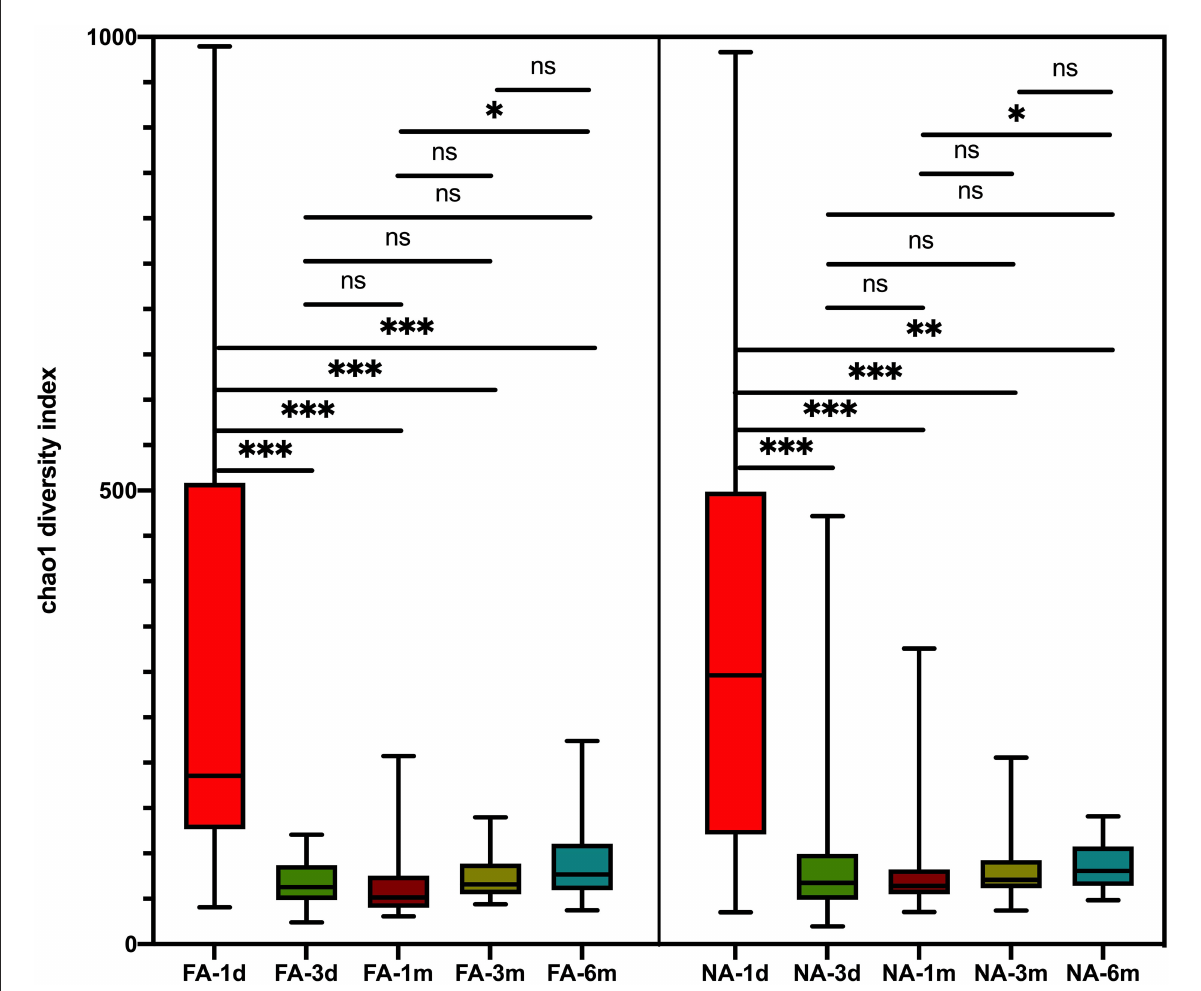
FIGURE2 Differences in variation over time of alpha diversity between the non-allergy (NA) and food allergy (FA) groups using the Chao1 index. The Wilcoxon test was used to analyze differences among time groups in the non-allergy and food allergy groups, respectively, * P < 0.05; ** P < 0.01; *** P < 0.001; ns, not